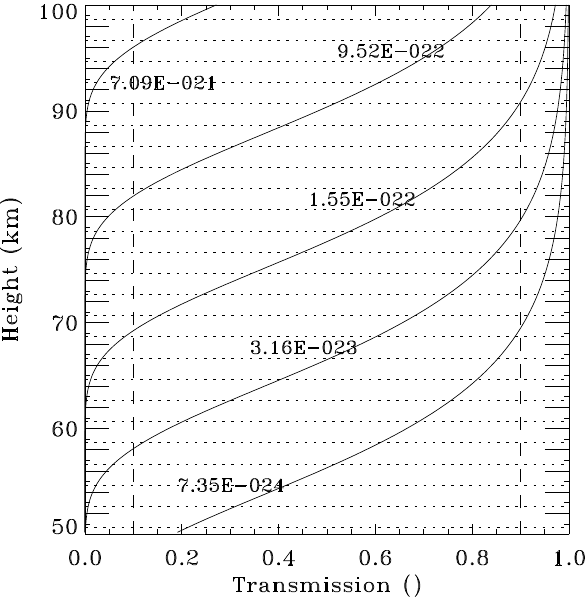
Fig. 1. Transmission profiles for the five SMAS-type channels as- sumed, each profile annotated with the associated O 2 absorption cross section value (cm 2 ) used. The dashed vertical lines bound the region, within which measurements are actually exploited. The dot- ted horizontal lines indicate the height levels (spaced at 2 km) used for the density, pressure, and temperature profiles in the numerical computations of the